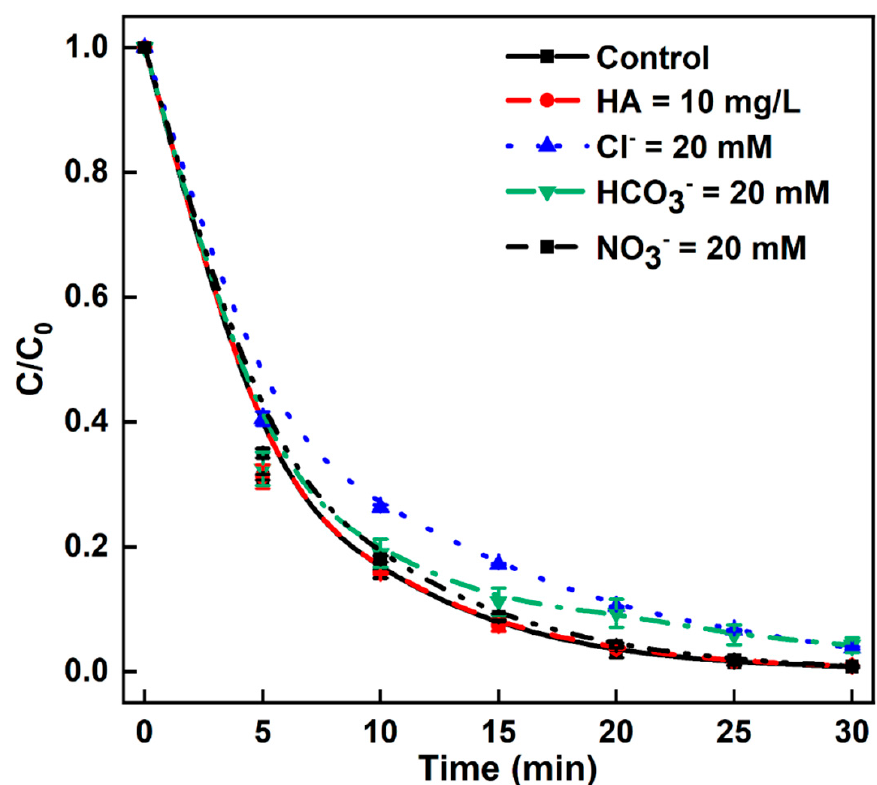
Figure 11. Effect of Cl − , HCO 3 − , NO 3 − and HA on the degradation efficiency of AO7. Reaction conditions: LLC800 = 0.25 g/L, PS = 4 g/L, AO7 = 200 mg/L and temperature = 25 °C.